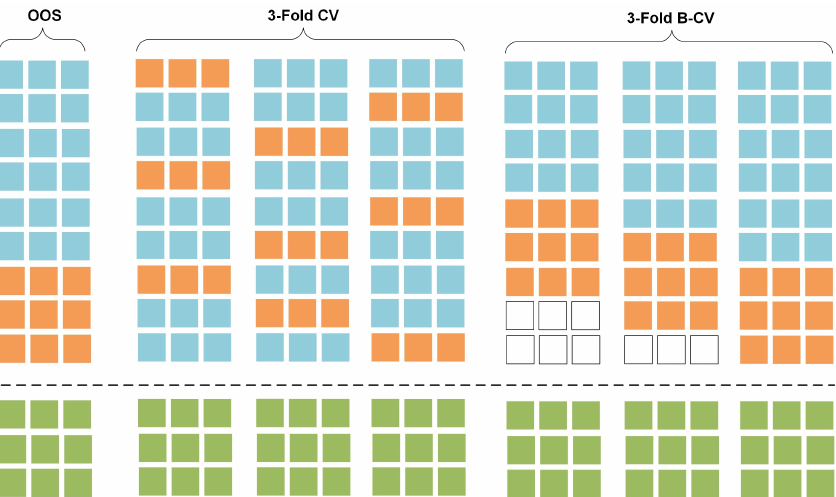
Figure 1. Conceptualization of data separation in model-validation. Training (blue), validation (orange) and test (green) datasets are shown for the OOS, 3-Fold CV and 3-Fold B-CV